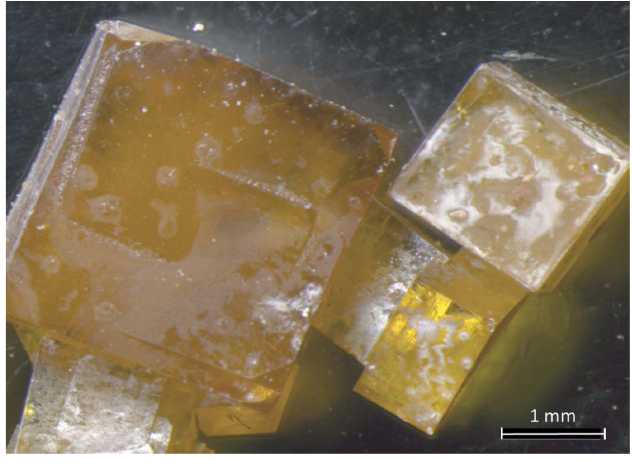
Figure 3 Photograph of Sn 3 TeO 8 single crystals grown by chemical vapor transport